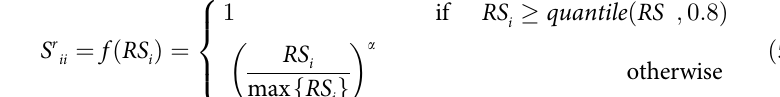
We projected this bipartite network into a mono-partite graph, the Projected Protein Layer ( PP-layer) , where protein nodes were connected through weighted links if they share common